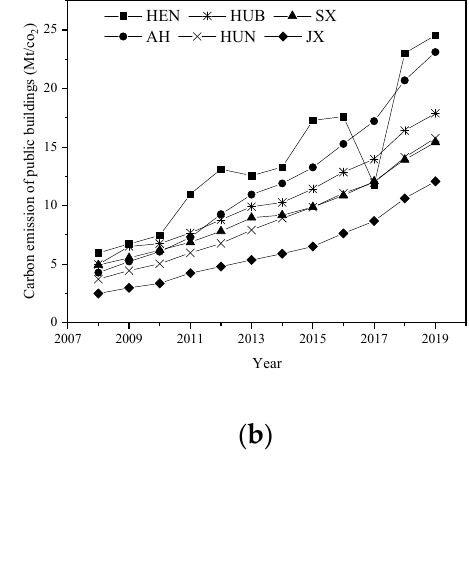
Table 5. Coefficient Thermal CO 2 emission (tCO 2 /MWh).